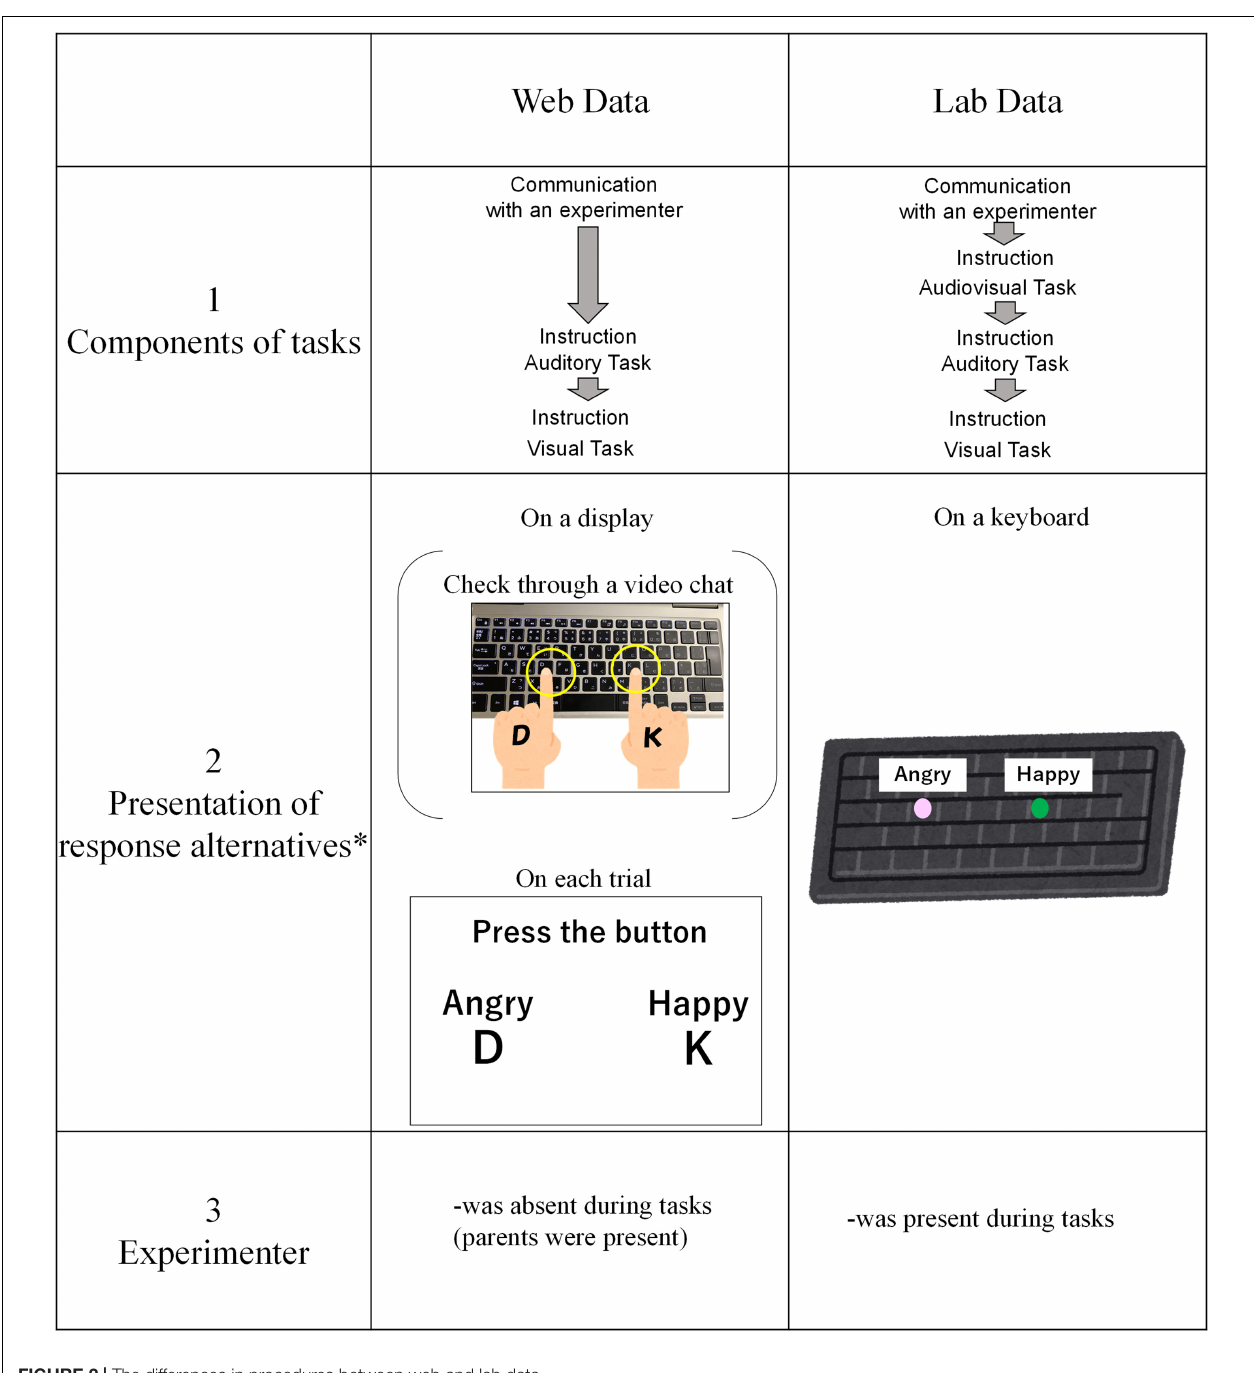
FIGURE 2 | The differences in procedures between web and lab